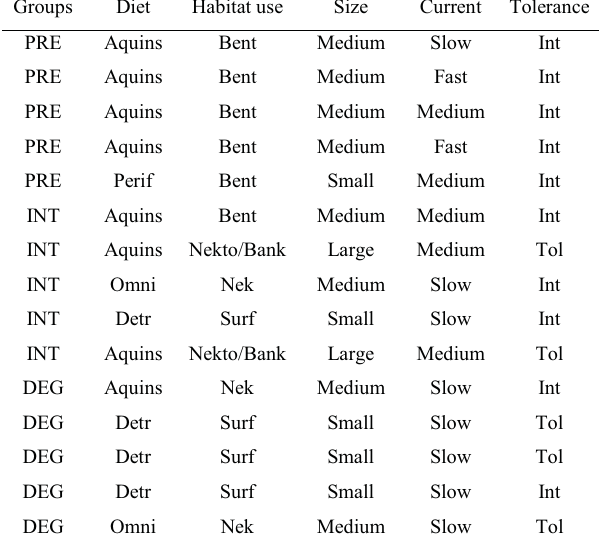
Table 3. Results of the community weighted mean of a trait (CWM) analysis for streams groups (PRE, preserved; INT, intermediate; DEG, degraded). Species features included: trophic group (Aquins, insectivores with predominance of aquatic forms; Carn, carnivores with predominance of invertebrates and fishes; Detr, detritivores; Omni, omnivores; Perif, periphytivores), habitat use (Bent, benthic; Nek, nektonics; Nekto/Bank, nektobenthic associated with stream banks; Surf, close to the surface of the water), size (Small, < 50 mm; Medium, 50-150 mm; Large, > 150 mm), preference for current (arbitrarily classified in Slow; Medium; Fast) and hypoxia tolerance (Tol, tolerant; Int,